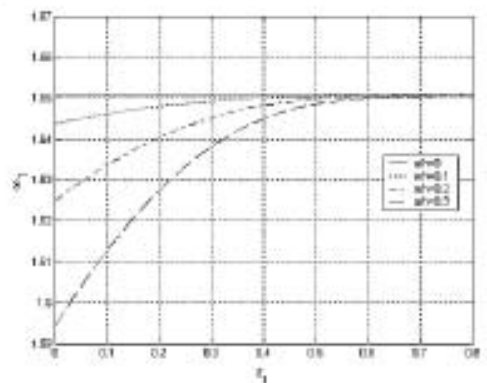
Fig. 6. The first structural frequency parameter of the coupled system as a function of the position of the crack. The fluid is considered to be compressible with sloshing.